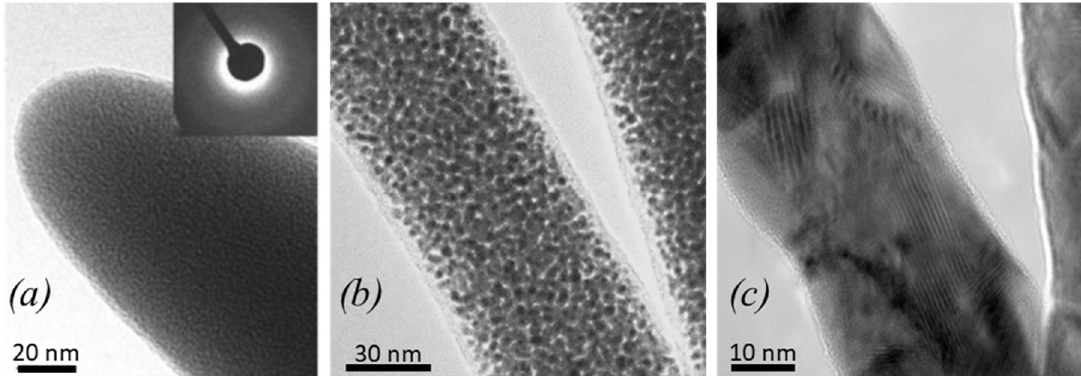
Figure 14. TEM images of FEBID nanopillars using differing precursors and post-treatments. ( a ) Amorphous dielectric Si-O-C tip from tetraethoxysilane (TEOS), fabricated at 25 keV/100 pA. ( b ) shows an Au-C nanopillar shaft fabricated at 30 keV/21 pA using Me 2 Au(acac) precursor, revealing 3–5 nm Au nanograins (dark), which are embedded in a carbon matrix (bright). ( c ) shows the same pillar after full purification using 5 keV/1.2 nA in 10 Pa H 2 O environments, where the highly crystalline Au character becomes evident. Of particular relevance is the widely maintained morphology, although diameters are strongly reduced (see scale bars). The remaining surface contamination by carbon due to the imaging is only about 1 nm, which becomes essential for plasmonic applications [75] .